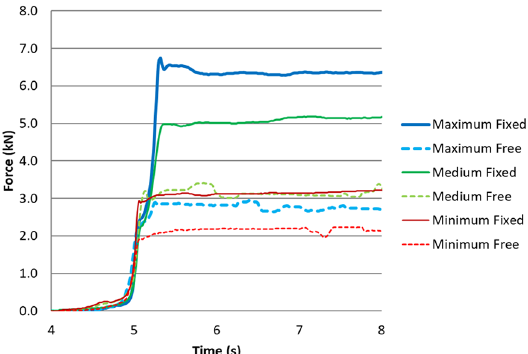
Figure 12. Vertical force measured on the pin during the BUT test.